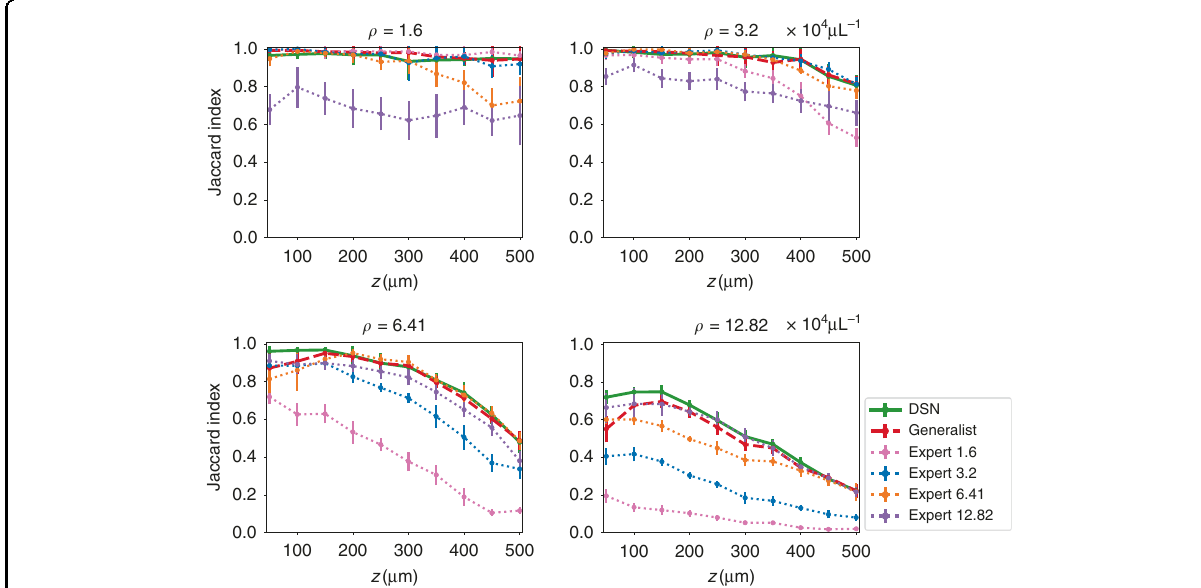
Fig. 3 Quantitative performance evaluation on seen densities. Particle localization performance is quantitatively compared between the DSN, the generalist, and the expert DNNs using JI. Each plot indicates the results on a test data set at the density labeled above each plot and with particle diameter 1.0 µm and refractive index contrast 0.26. “ Expert ρ ” represents the expert DNN trained on the data set with the density ρ (×10 4 particles μ L − 1 ). The DSN generally provides higher accuracy than both the generalist and the matching expert, in particular for high densities ( ρ ≥ 6.41 × 10 4 particles μ L − 1